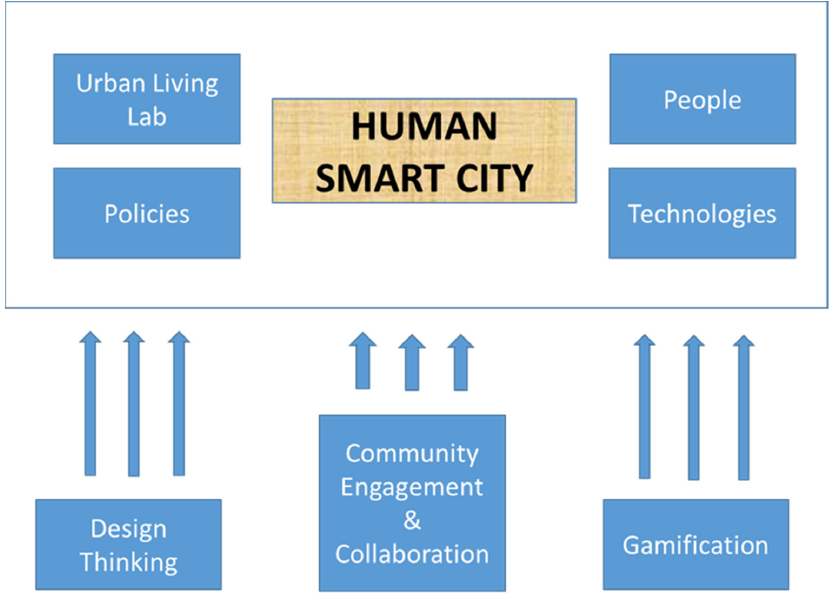
Figure 1. Human Smart Cities (HSC). Methodologies. Adapted from [19].